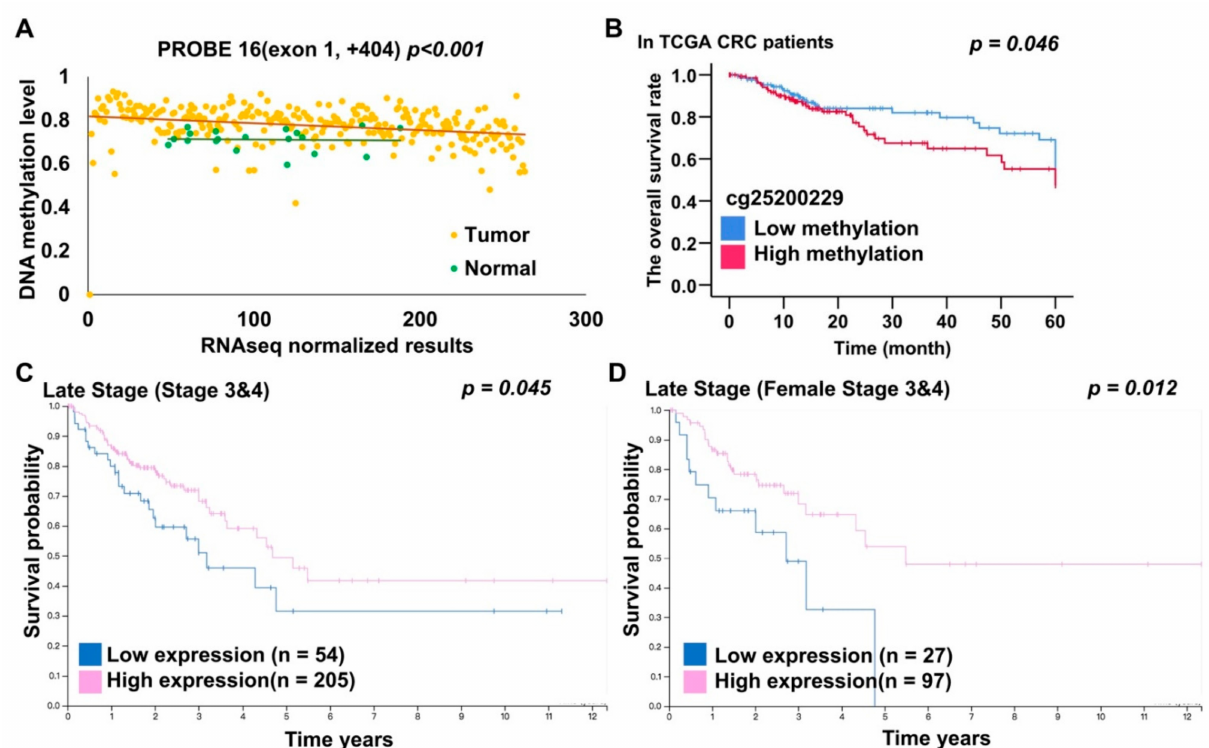
Figure 4. EHD3 DNA methylation, mRNA, and protein expression analysis from TCGA dataset. ( A ) The Pearson correlation test was used to estimate the correlation between EHD3 DNA methylation and RNA sequencing in 262 patients with CRC in the TCGA dataset. ( B ) The Kaplan–Meier estimate was used to compute the overall survival of patients with CRC with low and high EHD3 methylation levels. EHD3 was considered hypermethylated at an average β value of >0.445 (75th percentile). ( C ) The Kaplan–Meier estimate was used to compute the overall survival of patients with late-stage CRC with high and low EHD3 protein expression levels. Image credit: Human Protein Atlas. Image available from https://www.proteinatlas.org/ENSG00000013016-EHD3/pathology/colorectal+cancer#imid_15773055 (accessed on 27 July 2020). ( D ) The Kaplan–Meier estimate was used to compute the overall survival of female patients with late-stage CRC with high and low EHD3 protein expression levels. Image credit: Human Protein Atlas. Image available from https://www.proteinatlas.org/ENSG00000013016-EHD3/pathology/colorectal+cancer#imid_15773055 (accessed on 27